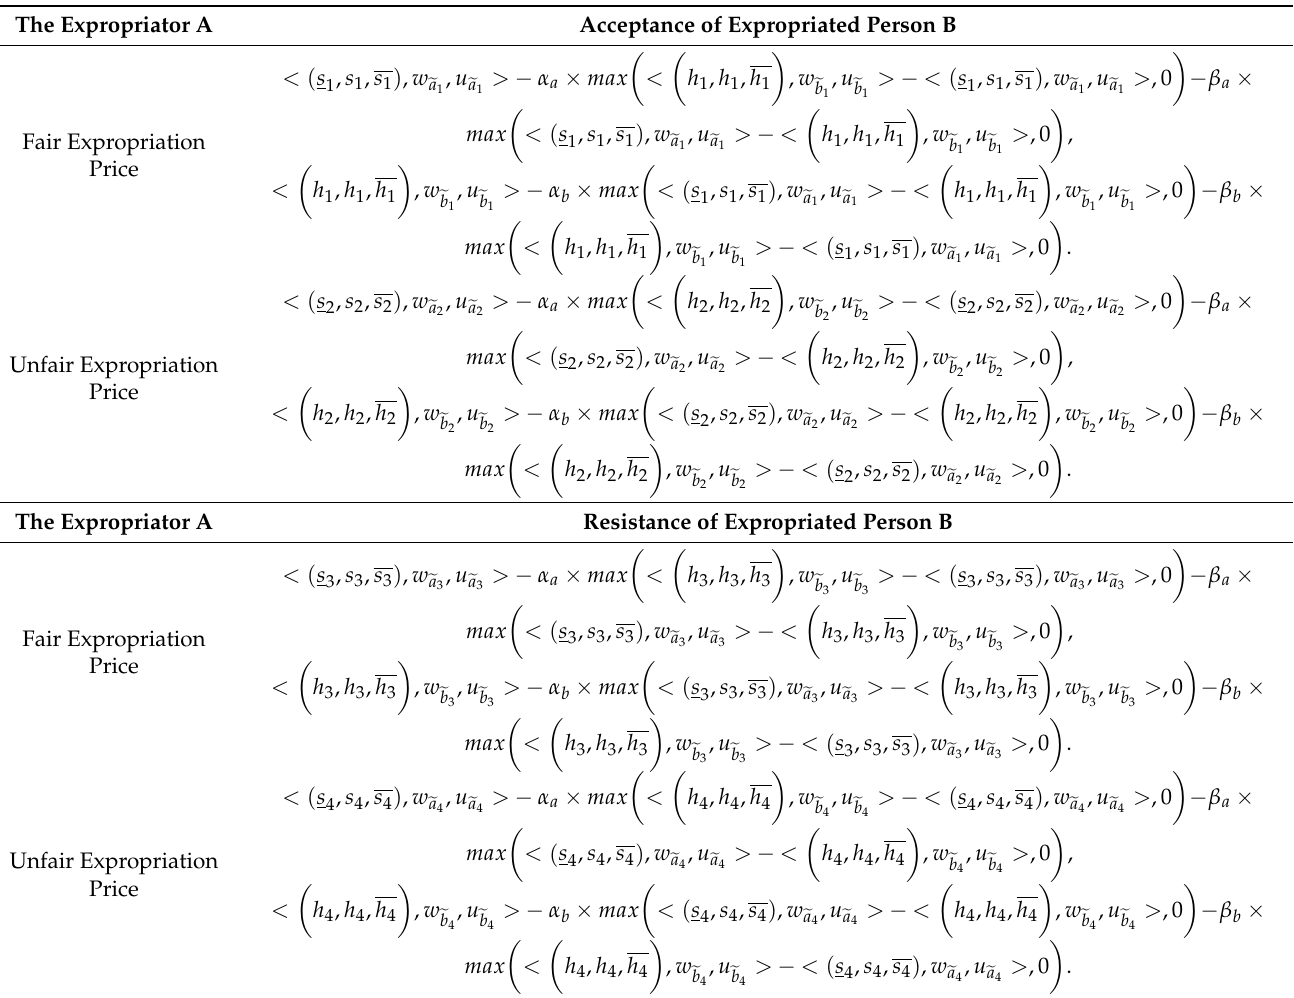
Table 3. Interactive fair fuzzy equilibrium evaluation